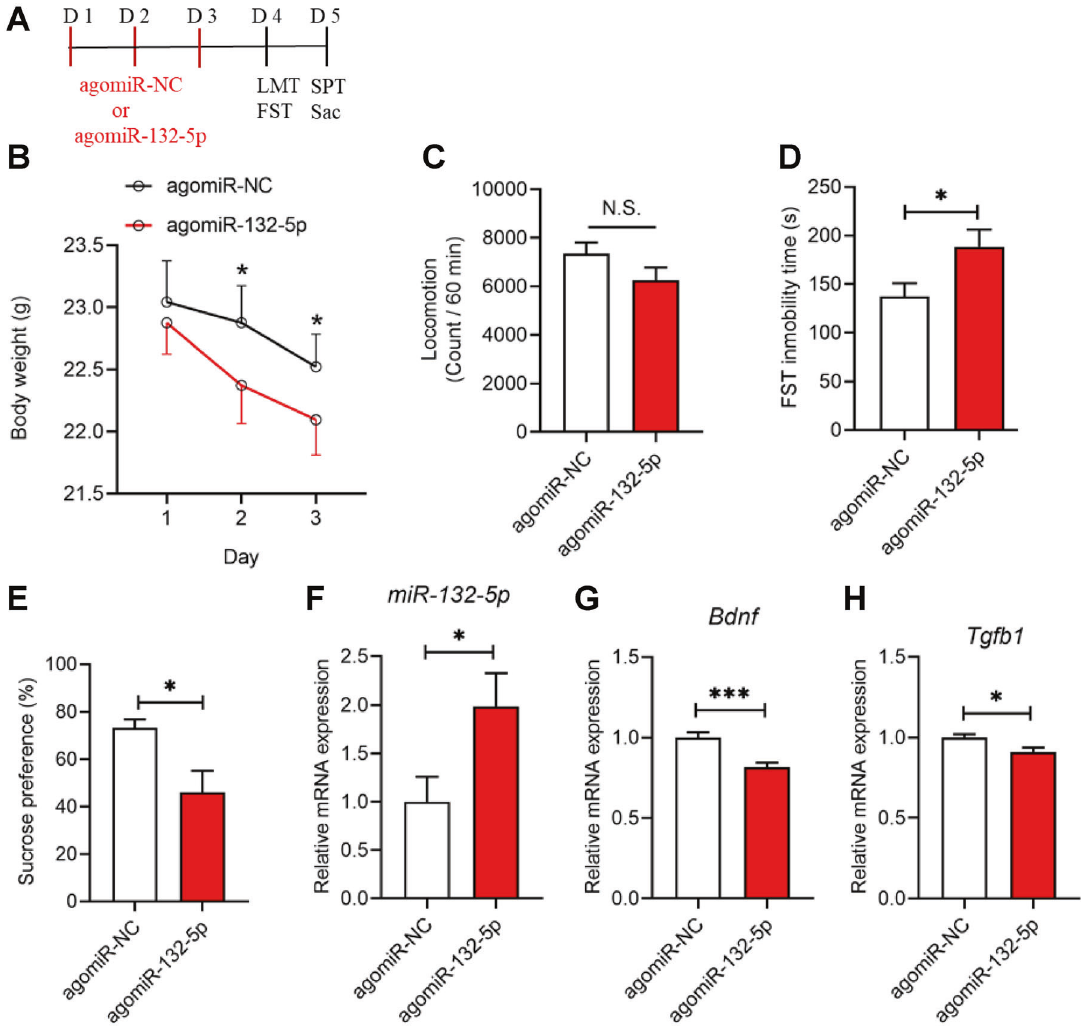
Fig. 4 Effects of miR-132-5p agomir on depression-like phenotype. A Treatment schedule. AgomiR-132-5p (200 nmol, 2 μ l/day) or agomiR- NC (control: 2 μ l/day) was administered i.c.v. to mice for 3 days (day 1 – day 3). Locomotion test (LMT), forced swimming test (FST) and sucrose preference test (SPT) were performed after the fi nal injection of agomiR-NC or agomiR-132-5p (day 4 and day 5). The prefrontal cortex (PFC) was collected after SPT. B Body weight change (two-way repeated measures ANOVA: F 2,36 = 3.765, P = 0.033). C Locomotion test (unpaired Student t-test: P = 0.129). D FST (unpaired Student t-test: P = 0.034). E SPT (unpaired Student t-test: P = 0.012). F Expression of miR-132-5p in the PFC (unpaired Student t-test: P = 0.033). G Bdnf mRNA in the PFC (unpaired Student t-test: P = 0.0005). ( H ): Tgfb1 mRNA in the PFC (unpaired Student t-test: P = 0.018). The data represent mean ± SEM ( n = 10). * P < 0.05, ** P < 0.01, *** P < 0.001. N.S., not signi fi